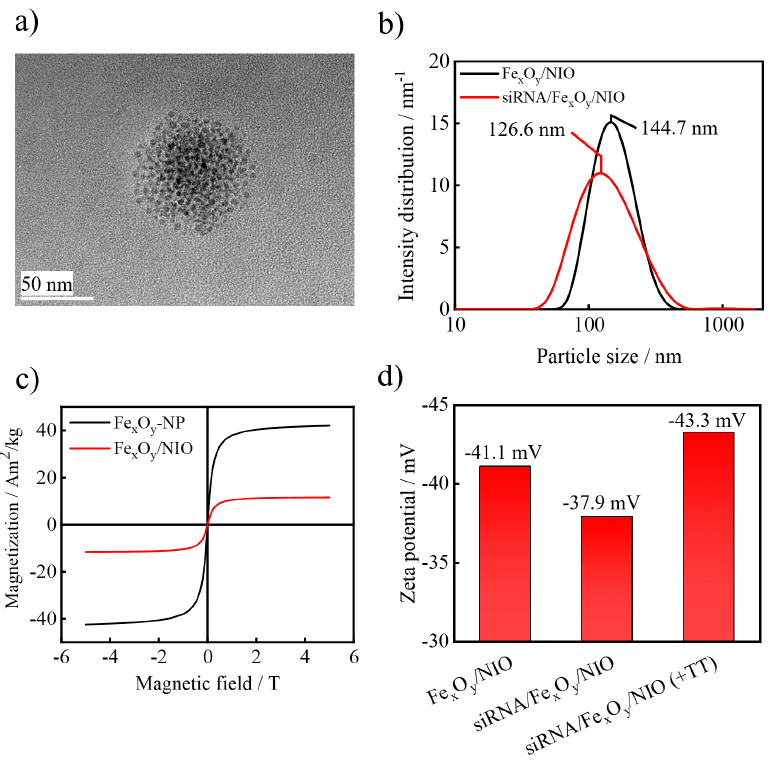
Figure 3. ( a ) Representative TEM image of Fe x O y /NIO (measured at 200 kV), ( b ) DLS result of plain Fe x O y /NIOs and siRNA/Fe x O y /NIOs, ( c ) magnetic behavior of the synthesized Fe x O y -NPs and Fe x O y /NIOs at 300 K determined by a superconducting quantum interference device (SQUID) magnetometer as well as ( d ) zeta potential measurements of plain Fe x O y /NIOs, siRNA/Fe x O y /NIOs and siRNA/Fe x O y /NIOs after trypsin treatment (+TT).